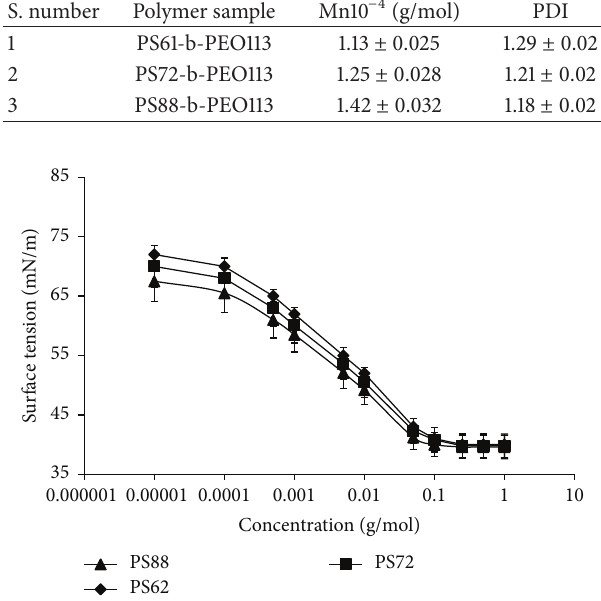
Figure 1: Surface tension of polymer samples as a function of poly- mer concentration, dissolved in water and measured at 25 ∘